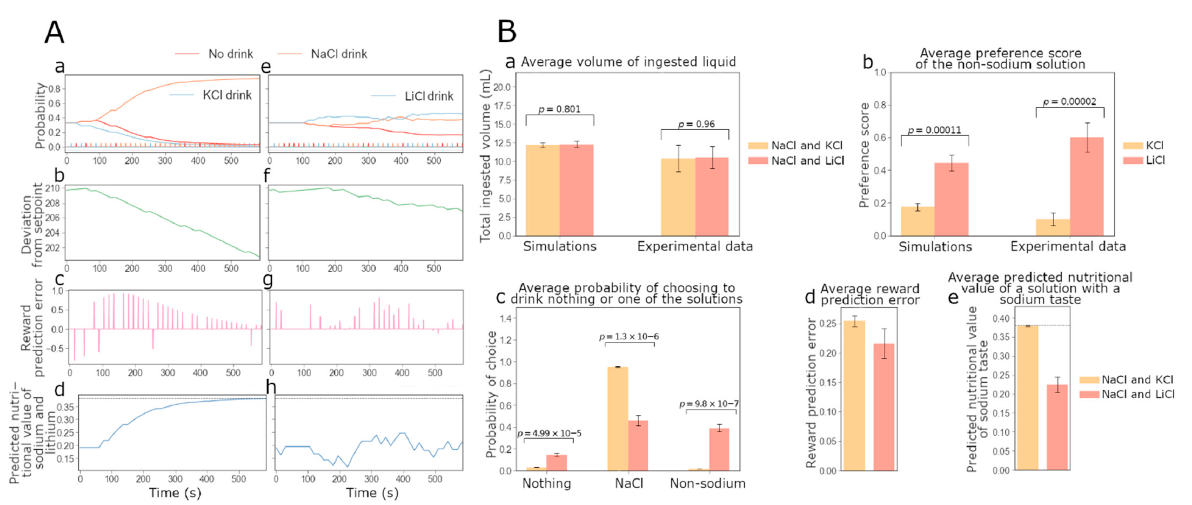
Figure 2. Simulations for the two-bottle intake test [17] are consistent with experimental observations on sodium appetite. Simulation results are shown for experiments where sodium-depleted rats have access to NaCl and KCl (left column, ( A ( a – d ))), and in the other version, NaCl and LiCl are the solutions available (right column, ( A ( e – h ))). Both versions of the experiment last 10 min (40 trials). ( A ) (left column): ( Aa ) Evolution of the choice probability for a simulated agent with optimized free parameters to consume NaCl, KCl or nothing over time (left). Evolution of the probability for an agent with optimized parameters to consume NaCl, LiCl or nothing over time (right). Note that the two simulated individuals are identical in the values of the free parameters: the discrepancy between their behaviors is due to the different solutions available to them. Note that the bars at the bottom indicate the individual choices (color codes the choice). ( Ab ) Amount of sodium ingested over time. Note that for these simulations, the optimal level of internal sodium for survival is set at 212 in arbitrary units. ( Ac ) Reward prediction error signals over time. Note that in our simulations the RPE is a proxy for the phasic dopamine signal. ( Ad ) Evolution of the approximated nutritional value ˆ K t for sodium and lithium. ( A(e – h )) panels show results corresponding to the left column but with NaCl and LiCl as choices. ( B ) Statistics of group simulation data (N = 28) under the two-bottle intake test (Fortin and Roitman [17]) accounts for quantitative experimental results on sodium appetite. As in the original study, 14 simulated rat agents take the version with KCl and 15 take the version with LiCl. The free parameter values for individual agents (N = 28) are all different and are sampled from the distributions near that optimized values used for example simulations in panels ( A ). ( Ba ) Average volumes of ingested liquid by rats (N = 28) during 10 min, in the simulated experiments and data (modified from Fortin and Roitman [17]). Intake volumes for rats that have access to NaCl and KCl (N = 14; yellow), and intake volumes for rats that have access to NaCl and LiCl (N = 15; red). ( Bb ) Average preference scores of rats (N = 28), in the model simulations and in experiments (modified from Fortin and Roitman [17]). Preference scores for KCl versus NaCl (N = 14; yellow), and preference scores for LiCl versus NaCl (N = 15; red). ( Bc ) Average probabilities (N = 28) to drink NaCl, the available non-sodium solution (KCl or LiCl) or nothing at the end of the 10 min experiment. Probabilities under access to NaCl and KCl (N = 14) are shown in yellow, and under access to NaCl and LiCl (N = 15) are shown in red. ( Bd ) Average reward prediction error (N = 28) during 10 min. The RPE under access to NaCl and KCl (N = 14) is shown in yellow, and the reward prediction error for access to NaCl and LiCl (N = 15) is shown in red. ( Be ) Average predicted value of a lick of sodium (or lithium) based on its taste (N = 28) at the end of the 10 min simulated experiment. This value for access to NaCl and KCl (N = 14) is shown in yellow, and it is shown in red for rats that have access to NaCl and LiCl (N = 15) ( p = 1.16 × 10 − 5 ). The true nutritive value of one lick of sodium is indicated with a dotted